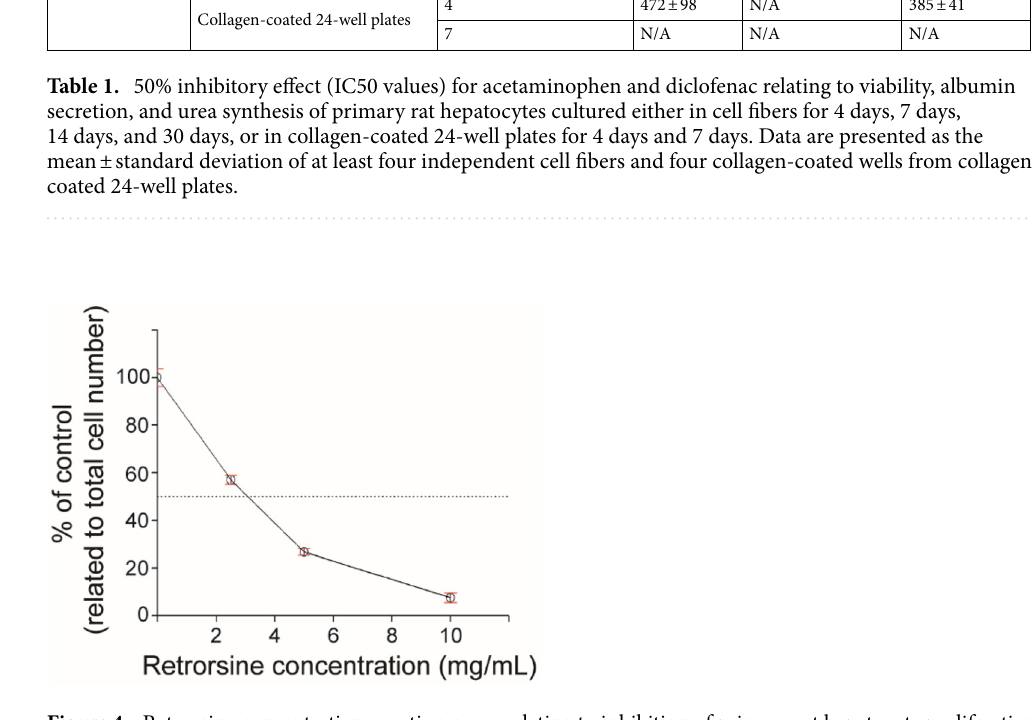
Figure 4. Retrorsine concentration-reaction curve relating to inhibition of primary rat hepatocyte proliferation in cell fibers in vitro. The effect of 24-h retrorsine treatment on inhibition of primary rat hepatocyte proliferation in cell fibers was evaluated using three different concentrations (2.5 mg mL −1 , 5 mg mL −1 , 10 mg mL −1 ) of retrorsine (n = 5 per data point). Error bars denote mean ±